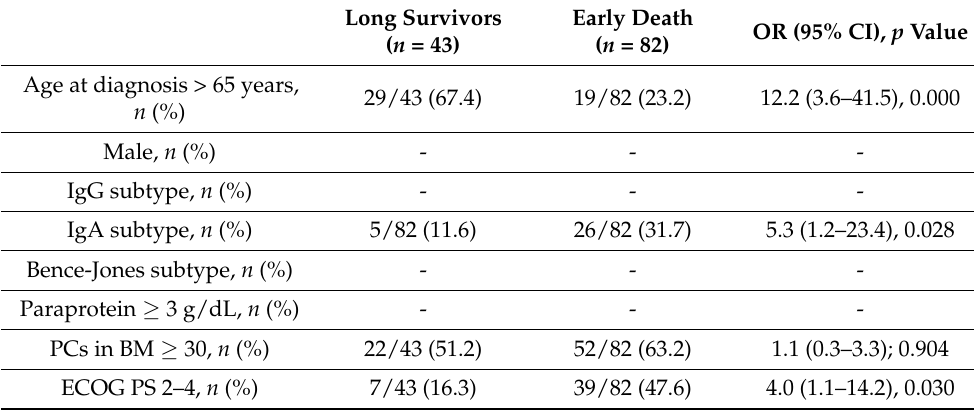
Table 4. Multivariable analysis: long survivors vs. early